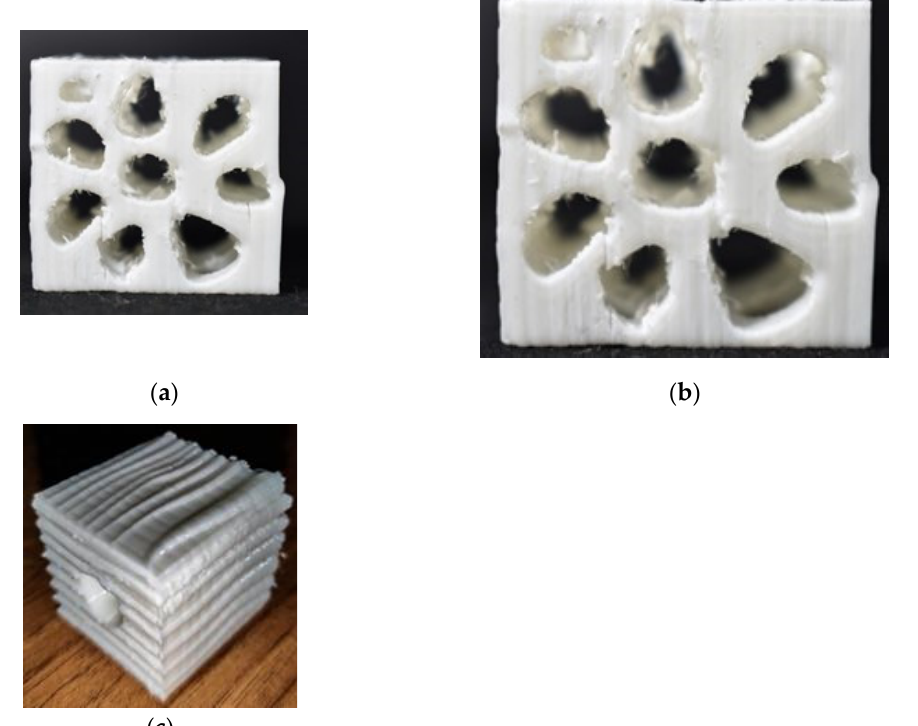
Table 2. Generic comparison of a few cases for mechanical strength.